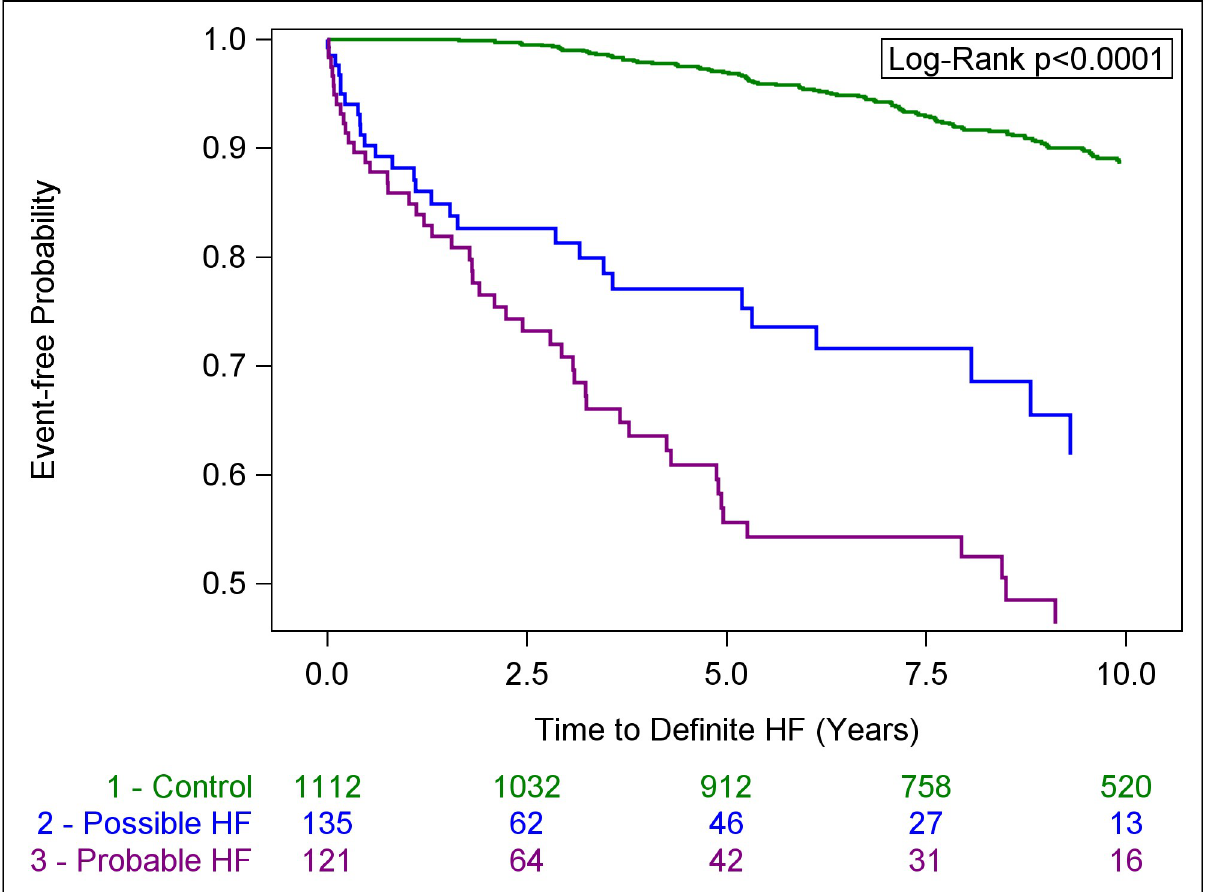
Fig 2. Kaplan-Meier curves for incident definite HF in control, possible HF and probable HF